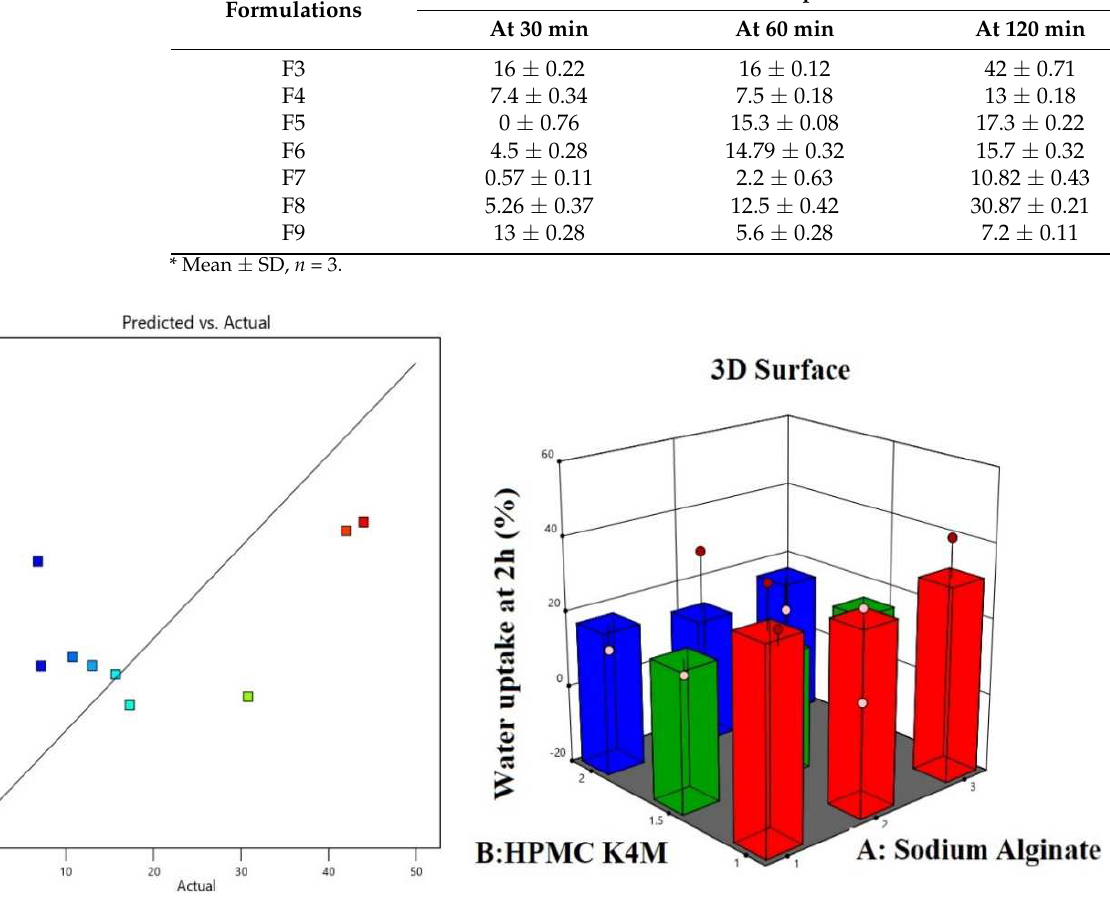
Figure 6. Predicted and actual value plots and 3D response surface plots showing the effect of independent variables, i.e., factor A (sodium alginate) and factor B (HPMC K4M), on % water uptake response at 2 h.